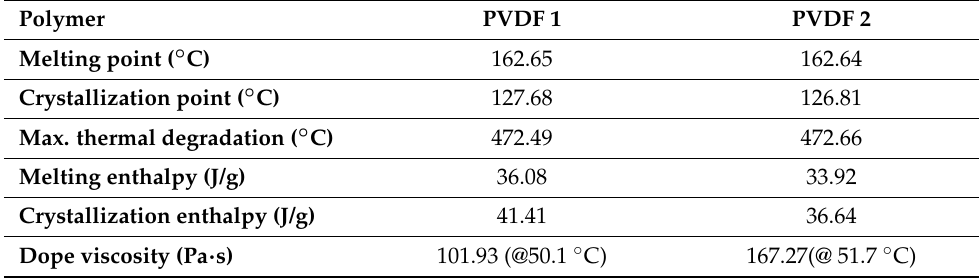
Table 1. Characterization of PVDF and dope